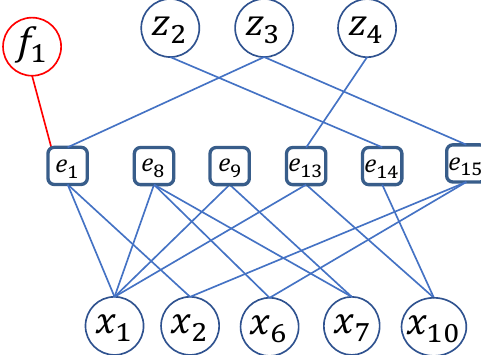
Figure 3. Bipartite graph of fault-driven minimal structurally overdetermined (FMSO) set ϕ 1 of the academic